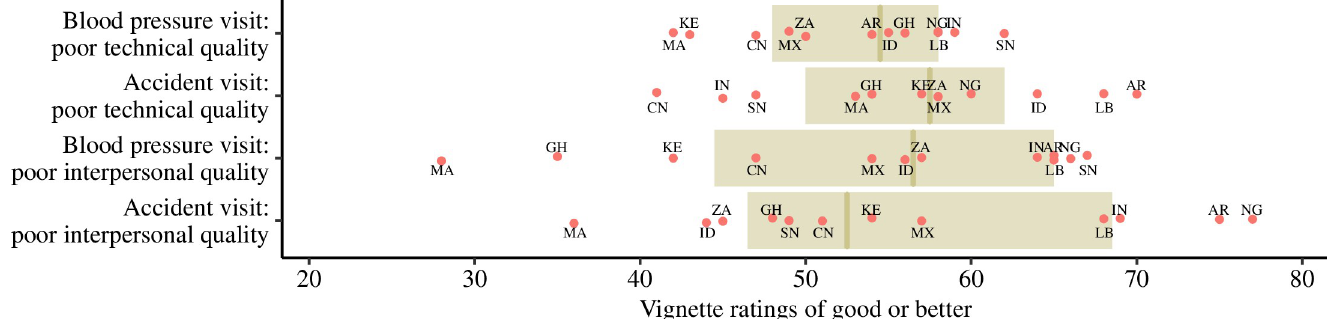
Fig 2. Ratings of good or better on vignettes describing poor-quality care. Blood pressure visit, poor technical quality vignette: N = 17,996. Accident visit, poor technical quality vignette: N = 3,640. Blood pressure visit, poor interpersonal quality vignette: N = 3,541. Accident visit, poor interpersonal quality vignette: N = 3,667. AR, Argentina; CN, China; GH, Ghana; ID, Indonesia; IN, India; KE, Kenya; LB, Lebanon; MA, Morocco; MX, Mexico; NG, Nigeria; SN, Senegal; ZA, South Africa.